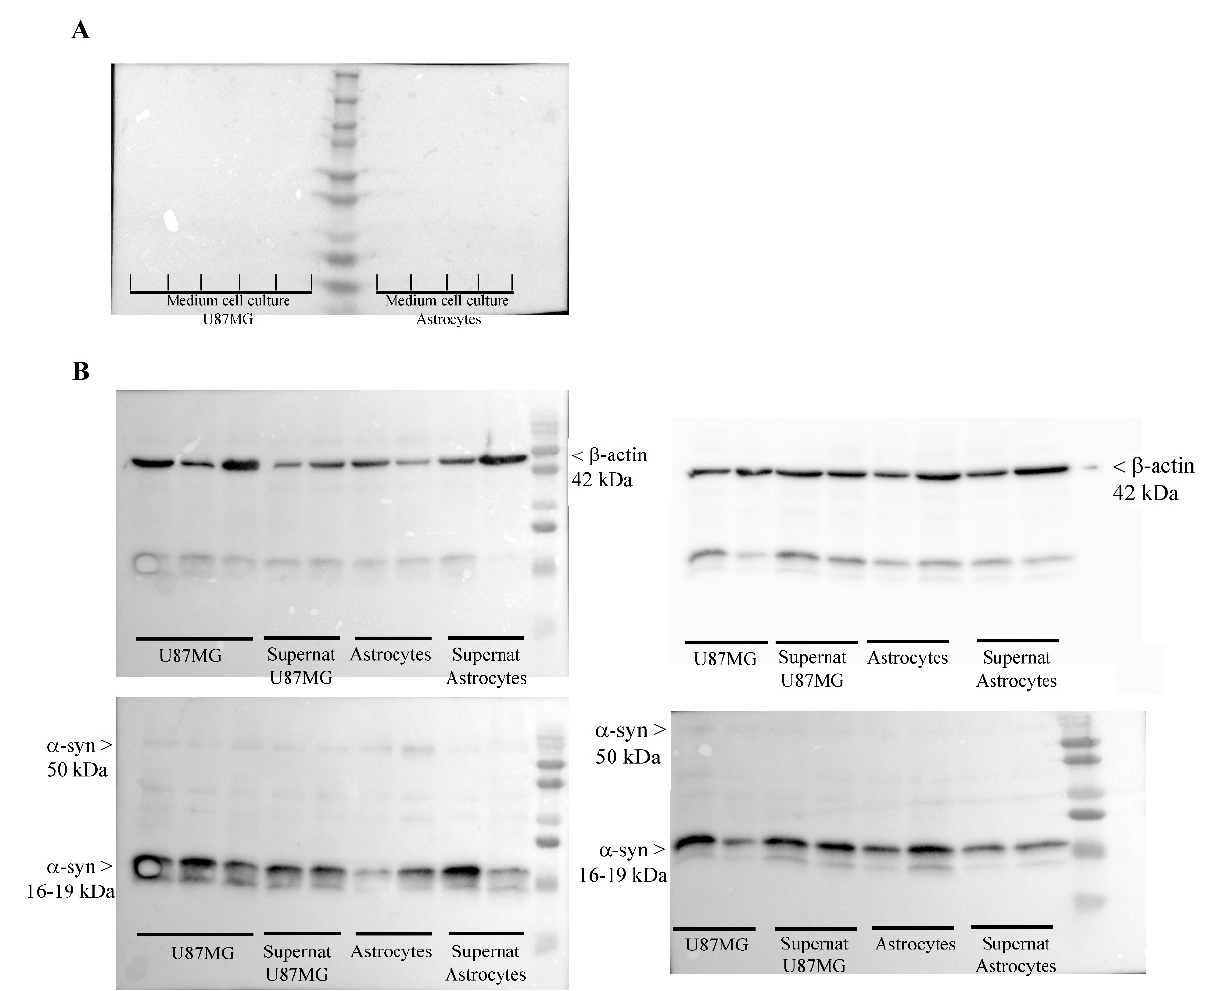
Figure 19. Western blotting of α -syn within cell supernatant and cell free medium. ( A ) Western blotting of the medium used for the trans-well system shows that no α -syn is detectable in the absence of either GBM cells or astrocytes, although the amount of medium being blotted corresponds to ninety-fold the amount, where a cell pellet grows. ( B ) Western blot of cell pellets and supernatant show very similar bands of α -syn. However, since the protein is blotted in a volume of supernatant, which exceeds almost ninety-fold that present in contact with the cell pellet, the real amount of α -syn detectable in the supernatant is very low compared with cell pellet. Supernat = supernatant.